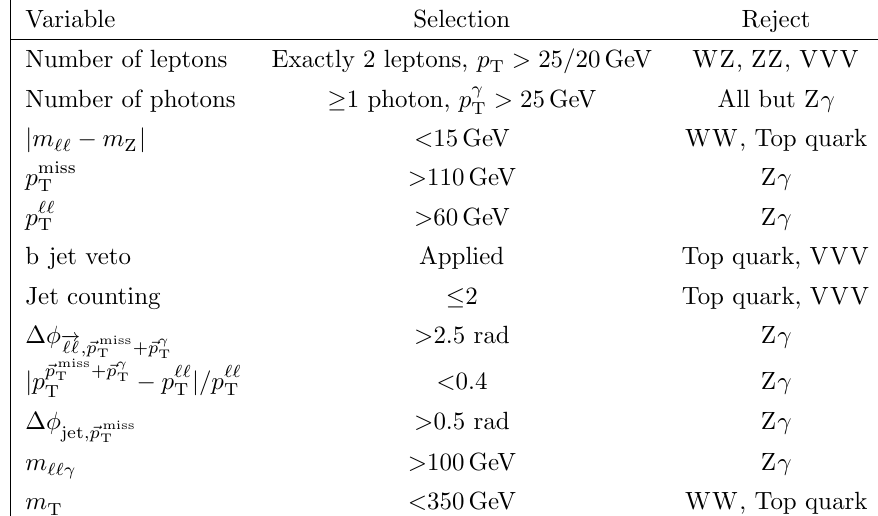
Table 1 . Summary of the selection criteria and the main background processes.